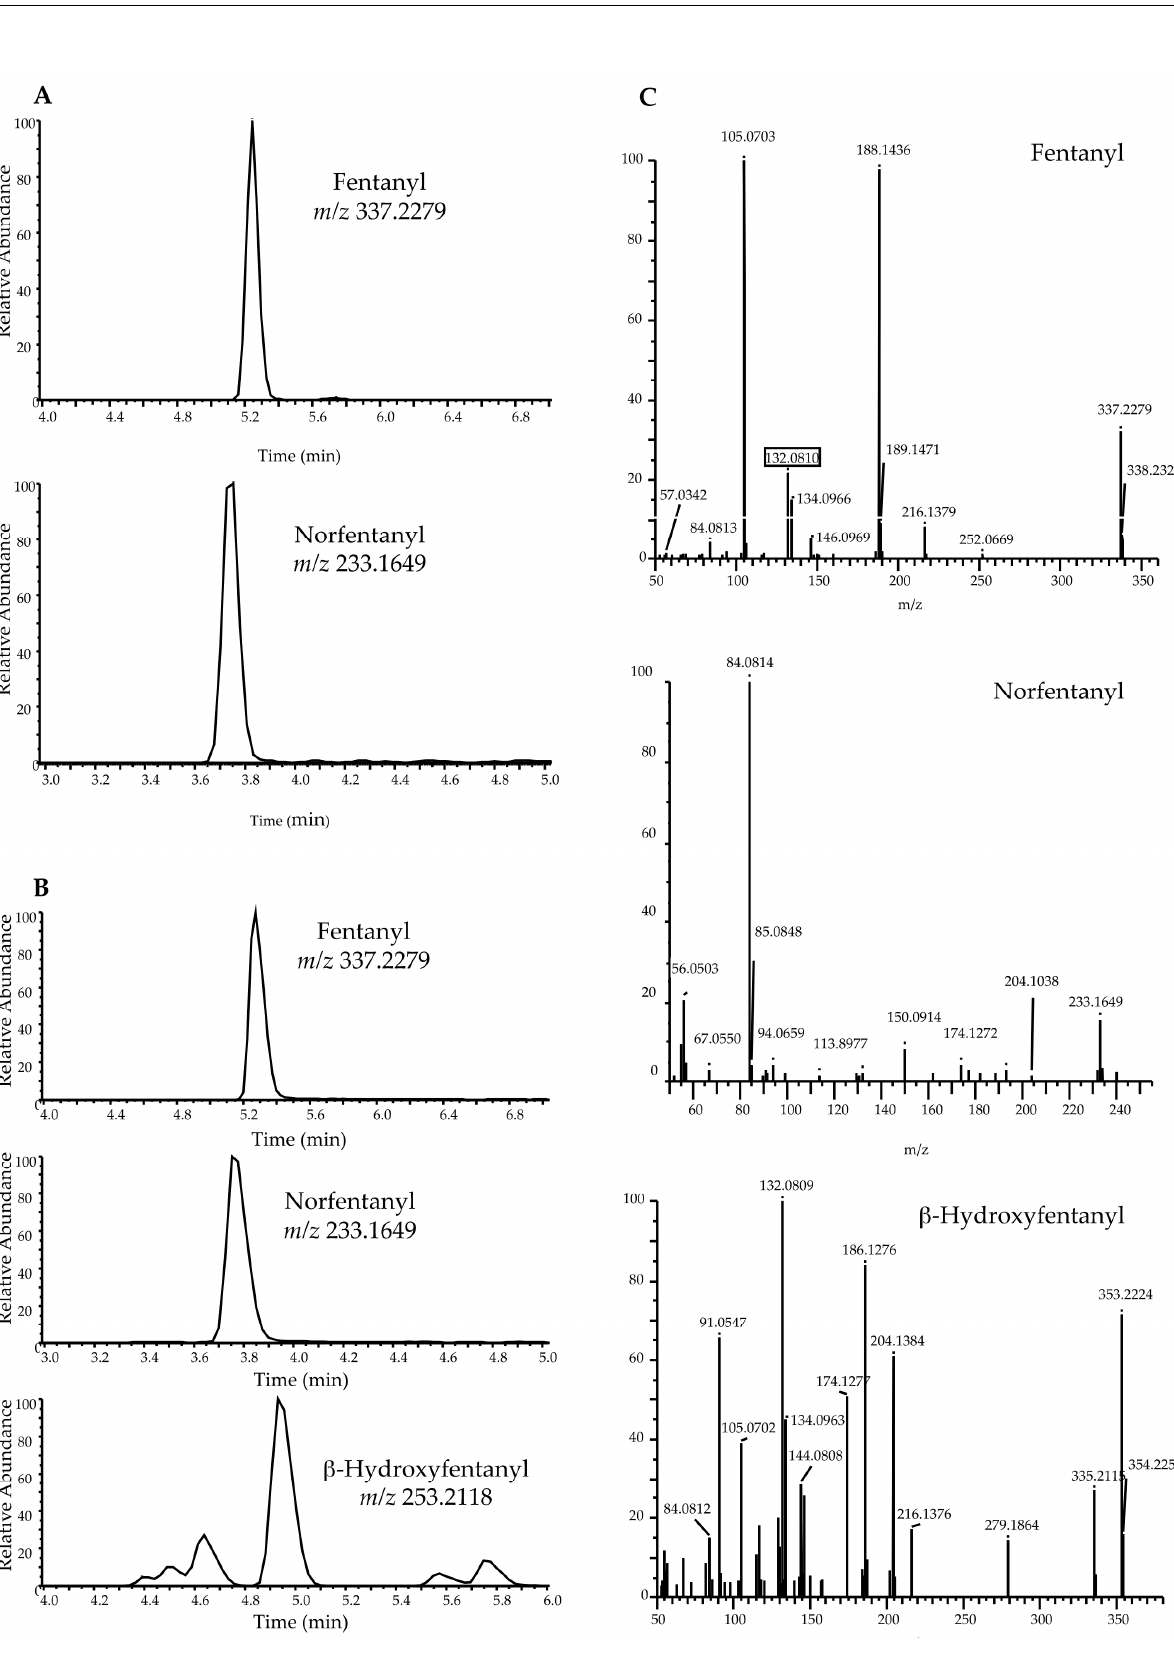
Figure 3. Representative extracted-ion UHPLC-HRMS chromatograms of: ( A ) urine sample positive to Fentanyl and Norfentanyl ( B ) urine sample positive to Fentanyl, Norfentanyl and β -hydroxyfentanyl and MS/MS full scan mass spectrum used for substances identification ( C